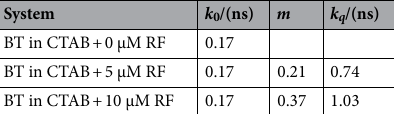
Table 3. Values of quenching parameters obtained from simplified infelta tachiya model.